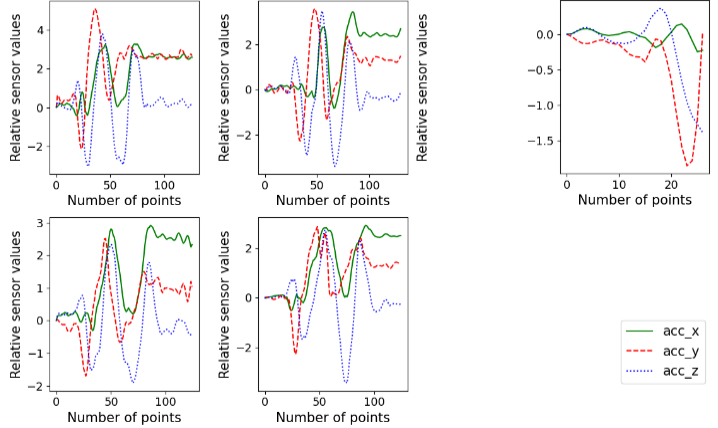
Figure 7. Example of normal ( left ) and corrupted ( right ) signals of Arabic numeral 9 written by a participant.